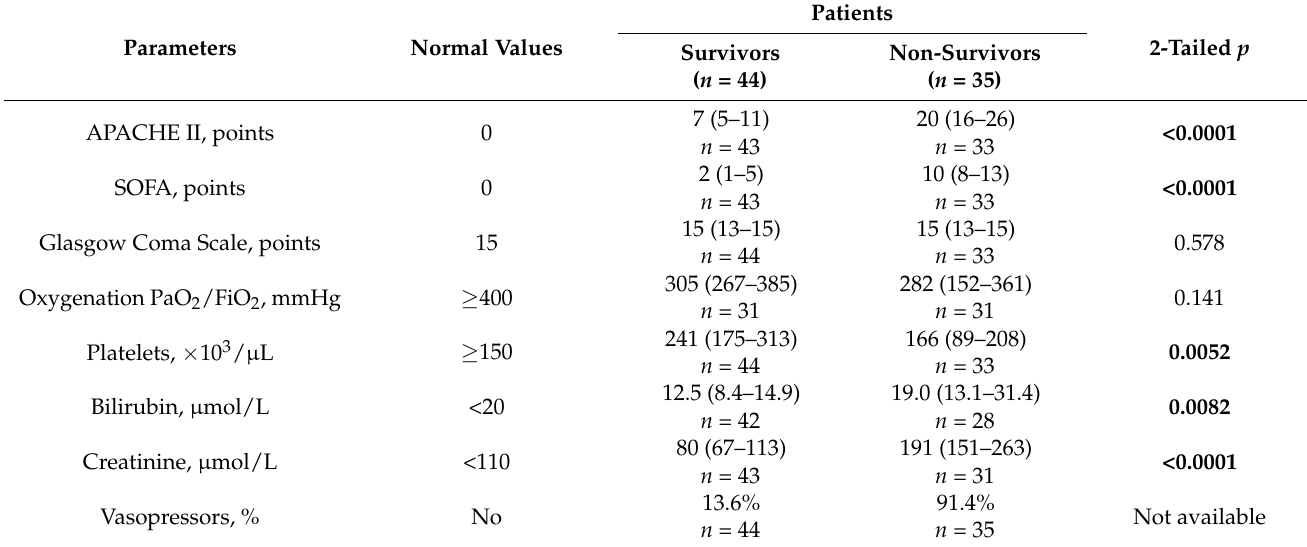
Table 2. Characteristics of the critically ill patients ( n = 79), and the results of the clinical and biochemical analysis of their serum samples taken on the day of admission to the intensive care unit. Data are presented as median and interquartile range (25–75%), for vasopressors–% of the prescriptions. For each parameter n indicates the number of patients in whom this parameter has been measured. The results for the Mann–Whitney U-test for the comparison of the independent groups of survivors and non-survivors, which are significant at p < 0.05, are highlighted in bold. The Holm–Bonferroni method was used to adjust p -values for multiple